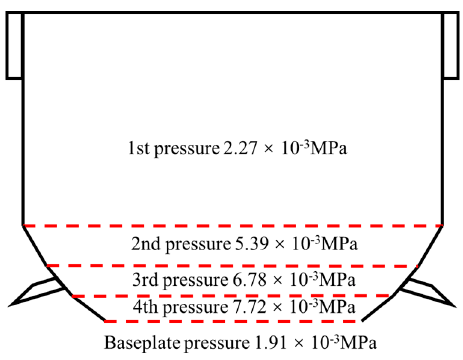
Figure 7. Pressure charts for each plate of the carriage.